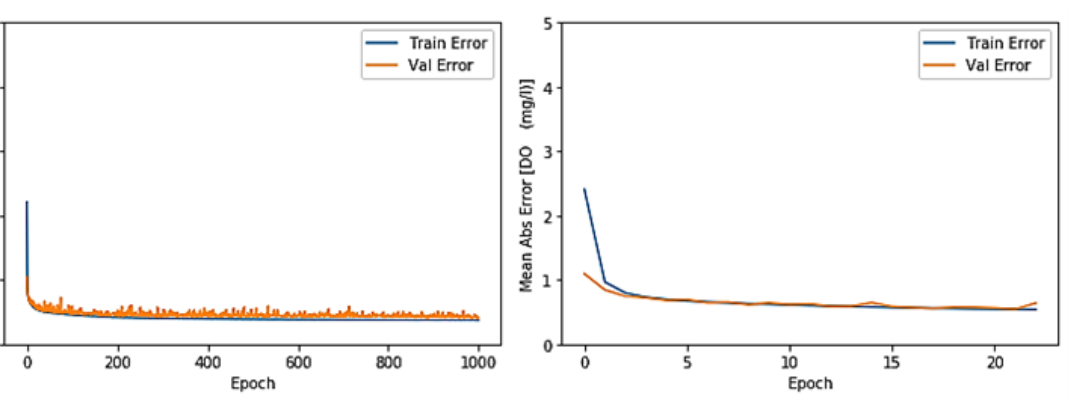
Figure 9. Mean absolute error (Toichio station, structure 7-32-32-1).